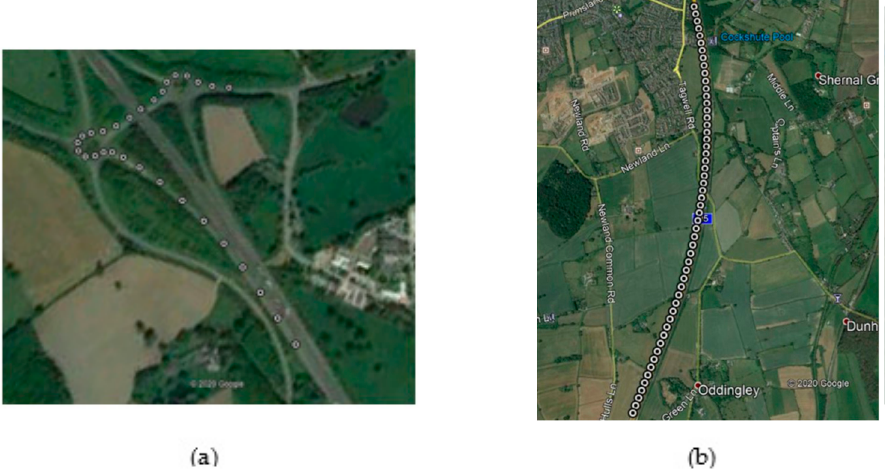
Figure 8. Sample trajectory of the (a) V-Vta11 roundabout data subset of the Inertia and Odometry Vehicle Navigation Dataset (IO-VNBD) and (b) V-Vw12 motorway data subset of the IOVNBD.